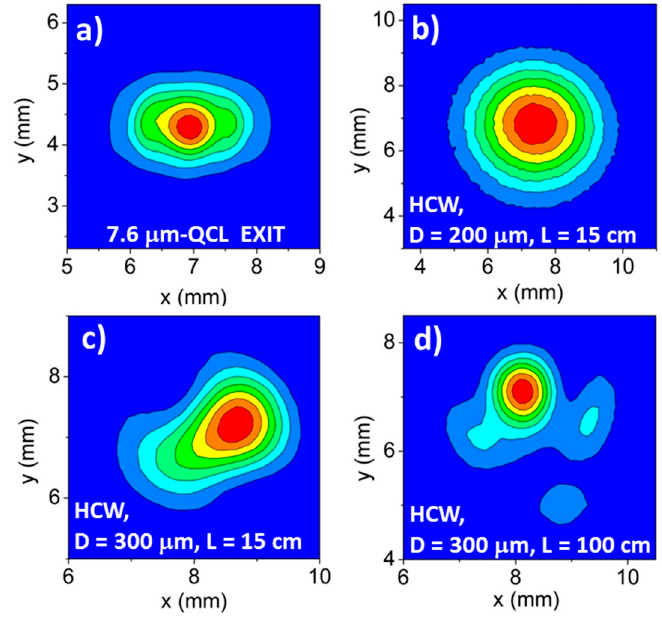
Figure 6. ( a ) Beam profile at the exit of DLS-QCL emitting at 7.6 μ m. ( b – d ) Beam profiles with a 200- μ m-core-sized and 15-cm-long HCW ( b ); 300- μ m-core-sized and 15-cm-long HCW ( c ); and 300- μ m-